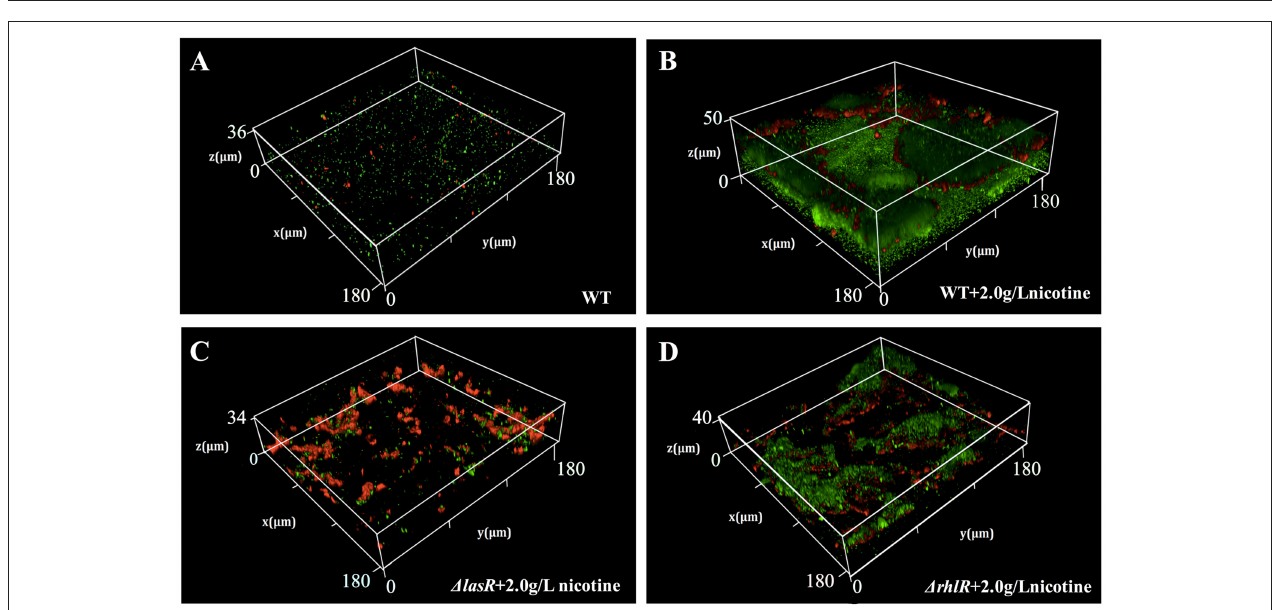
FIGURE 4 | Comparison of biofilm structure and proportion of live/dead cells (green, live cells; red, dead cells) in biofilm among WT (A) , WT + 2.0 g/L nicotine (B) , 1 lasR + 2.0 g/L nicotine (C) , and 1 rhlR + 2.0 g/L nicotine (D) .